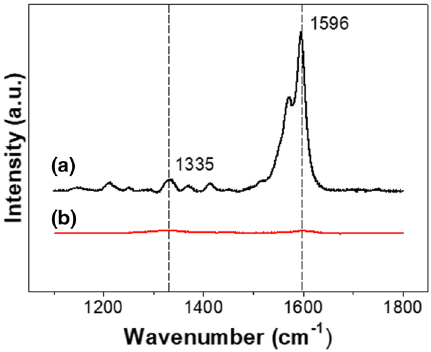
Fig. 3 Raman spectra of SWCNT films recorded from SWCNTs a protected with a photoresist polymer, and b exposed to O 2 ‑plasma